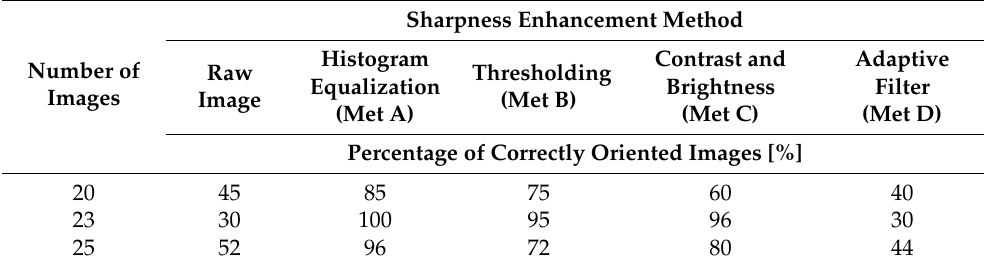
Table 4. Number of images with correctly automatically identified calibration targets.